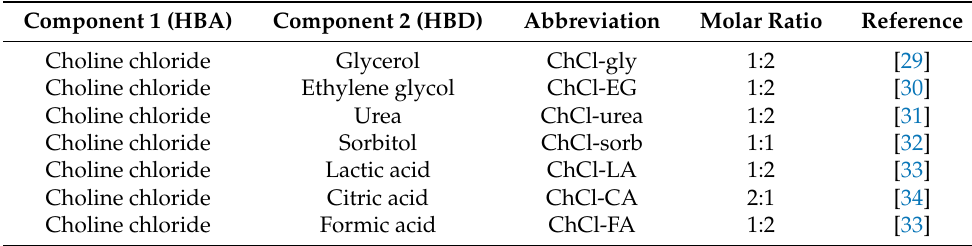
Table 1. Hydrogen bond acceptors (HBAs) and hydrogen bond donors (HBDs) employed in the synthesis of natural deep eutectic solvents